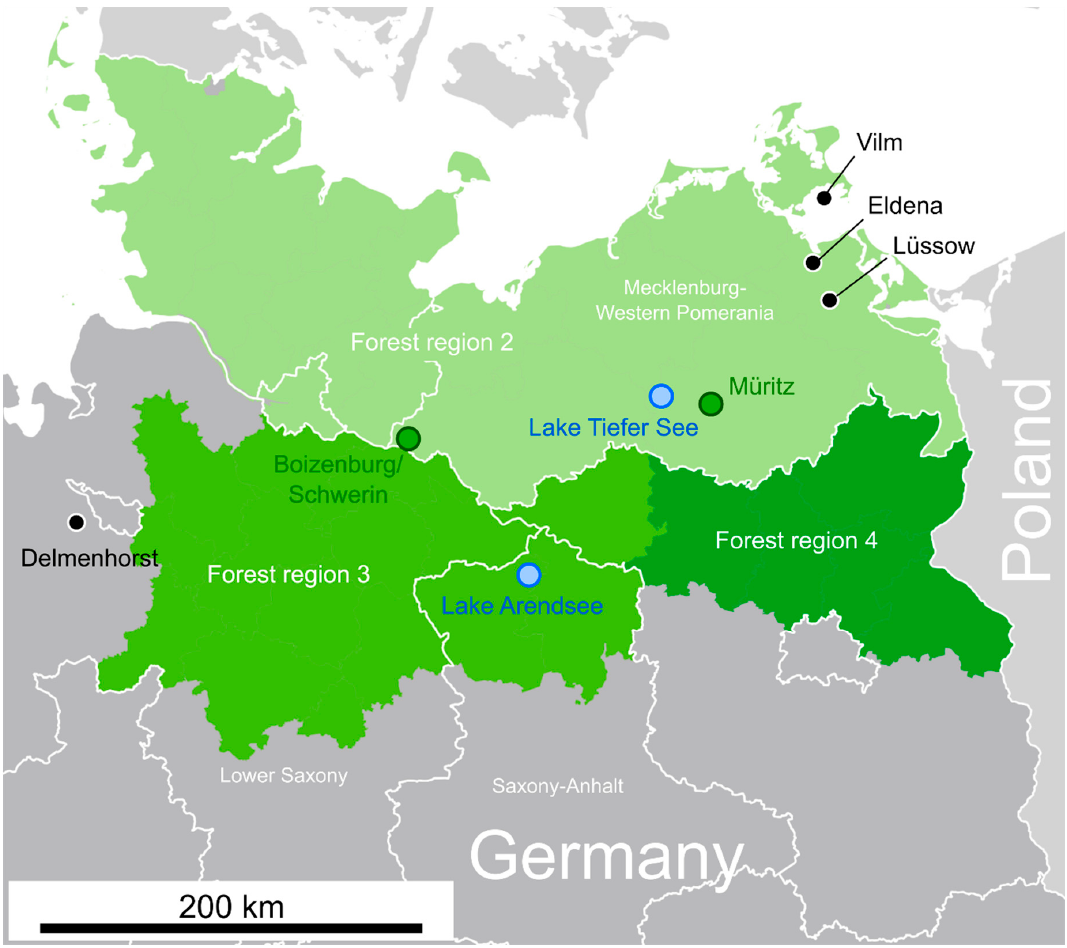
Figure 1. Map of the study area, indicating Lake Tiefer See and Lake Arendsee, and position of the pollen traps in Delmenhorst, Vilm, Eldena and Lüssow, as well as position of tree-ring study sites. Green areas indicate forest regions, for which flowering data are recorded.